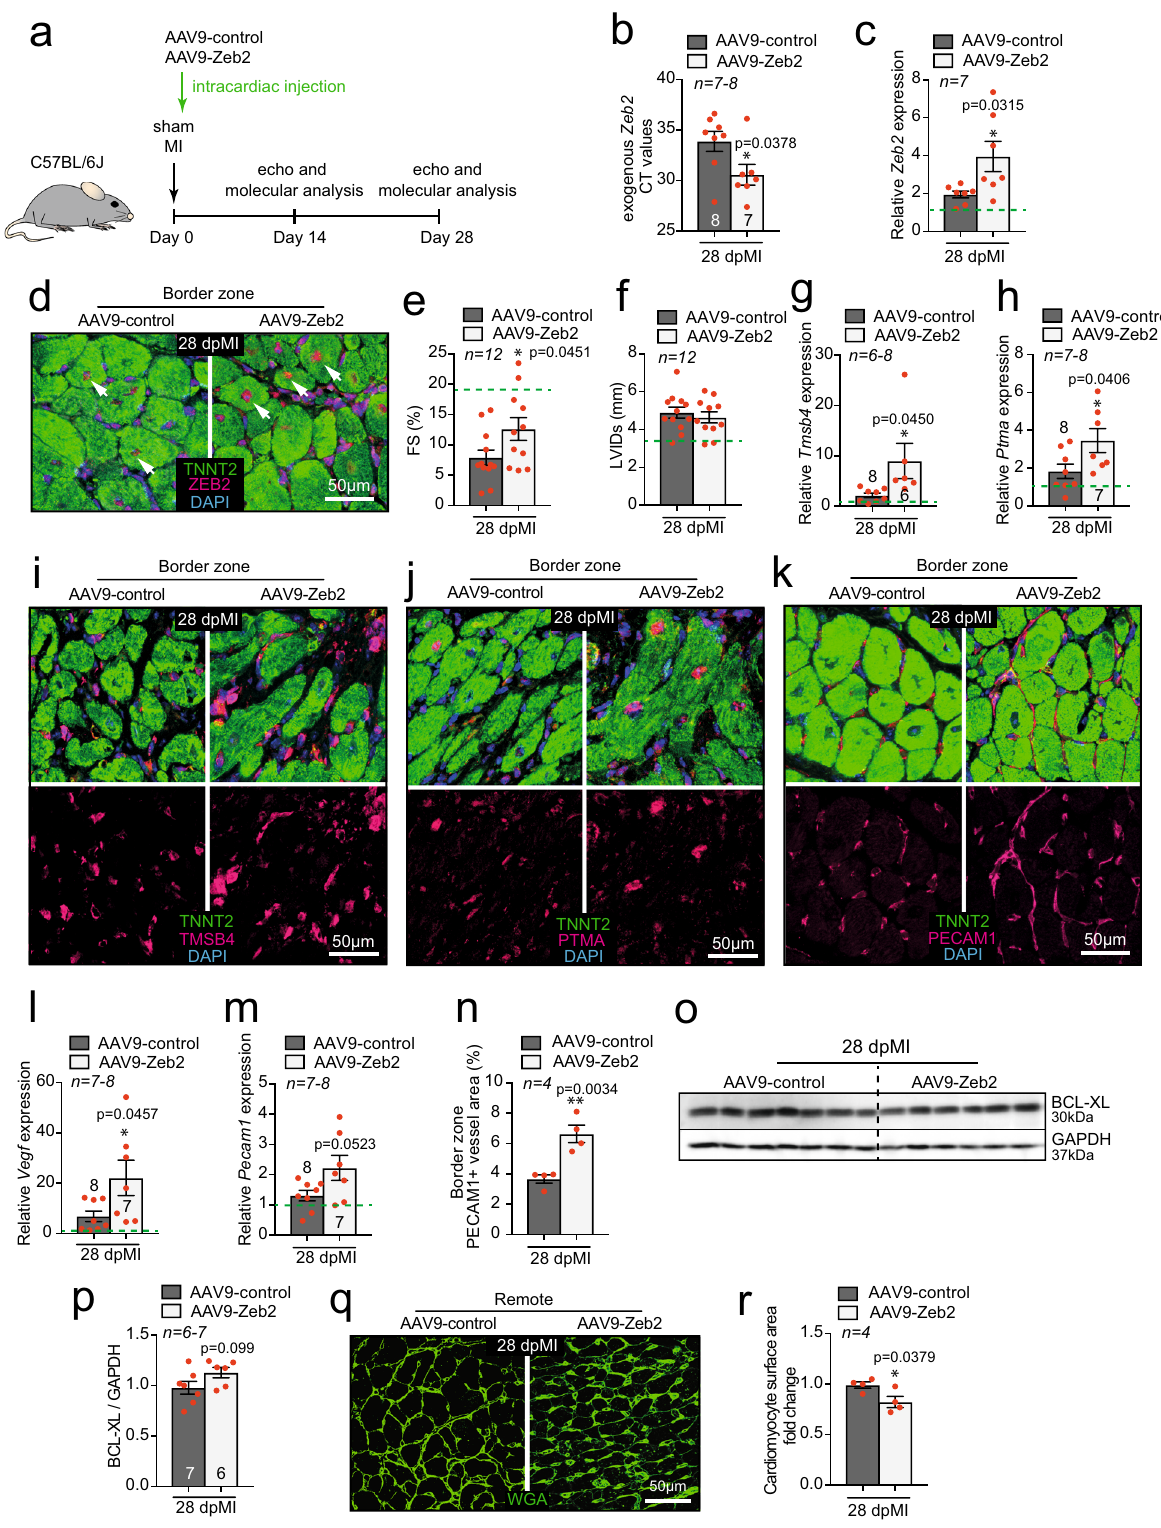
placed around the LAD. Successful ligation of the coronary artery was de fi nite by whitening of the heart anterior wall. After the surgery, the rib cage was closed with 5.0 silk suture, and the skin closed with a wound clip. The animal was disconnected from the ventilator, the tracheal tube removed, and placed on a nose cone with 100% oxygen. To alleviate pain or discomfort after the surgery, mice were injected with 0.05 – 0.1mg/kg of Buprenorphine. During the whole procedure and recovery period animals were placed on a 38 °C hot plate. Cardiac function was evaluated